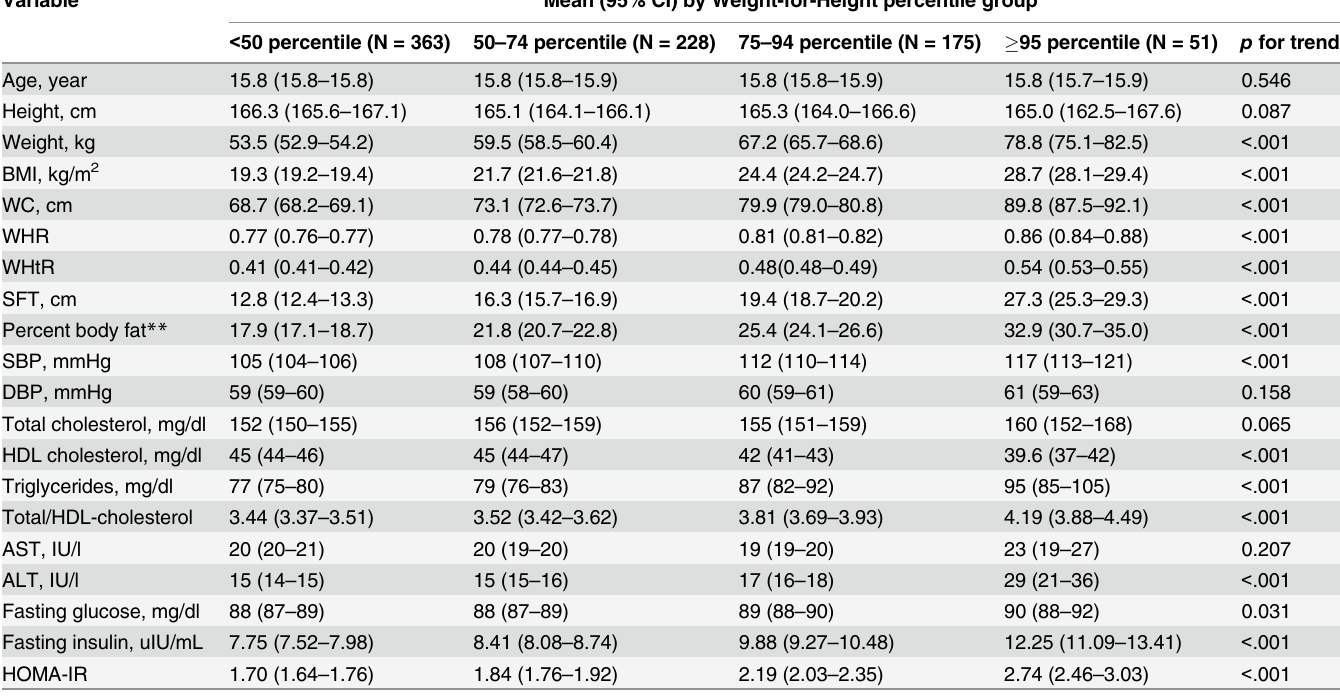
Table 2. Metabolic Characteristics by Weight-for-Height